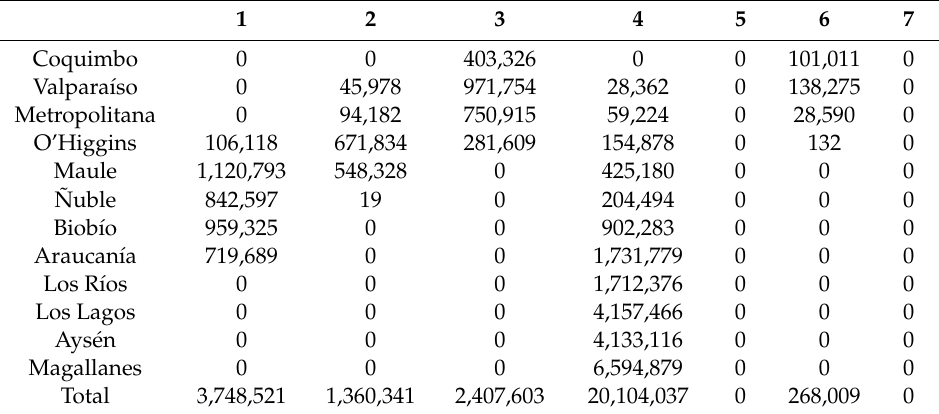
1: Suitable land with a humid regime; 2: Suitable area 3 with a subhumid regime; 3: Marginal area (water deficit); 4: Marginal area (temperature); 5: Marginal area (frost); 6: Marginal area (temperature and water deficit); 7: Marginal area (water deficit and frost).